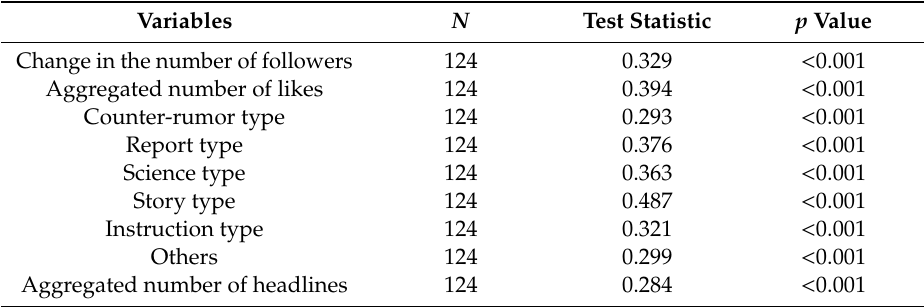
Table 4. Results of one-sample Kolmogorov–Smirnov